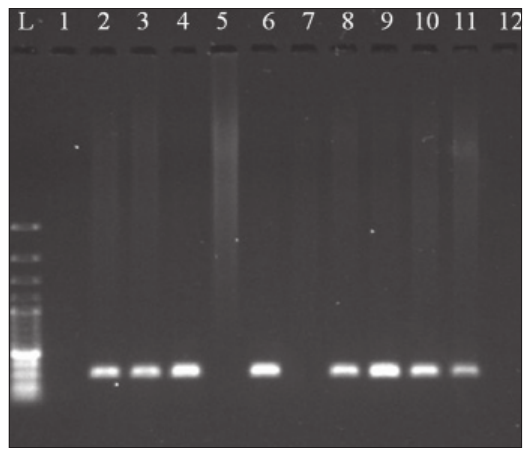
Figure-2: Gel electrophoresis results of polymerase chain reaction products showing specific amplification of 312 bp. L-Ladder 100bp; 1- Control negative; 2- Control positive; 3-12- Test samples; 5,7 and 12- Negative; 3,4,6,8,9,10,11-Positive.